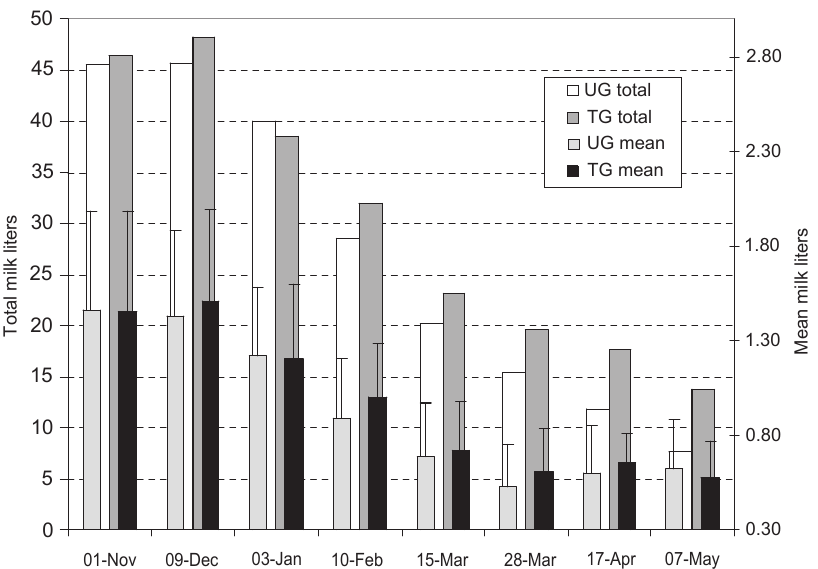
Fig. 2. – Total and mean milk pro- duction per group on sampling days. UG: untreated group and TG: monthly treated group.